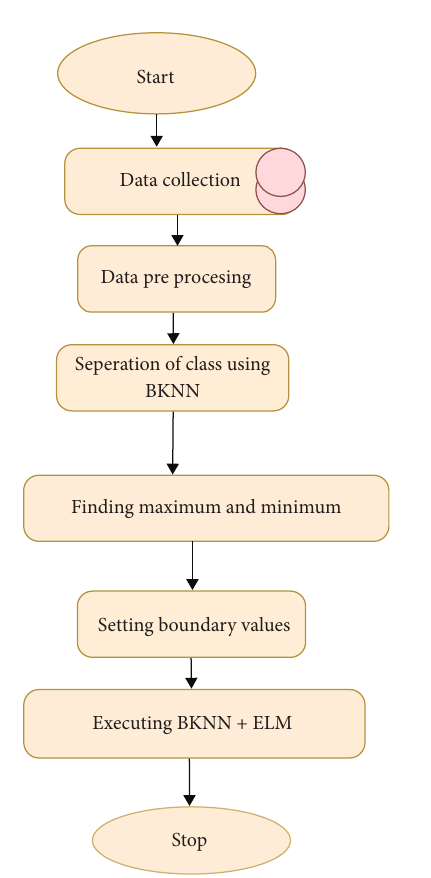
Figure 2: Flow chart of proposed work.